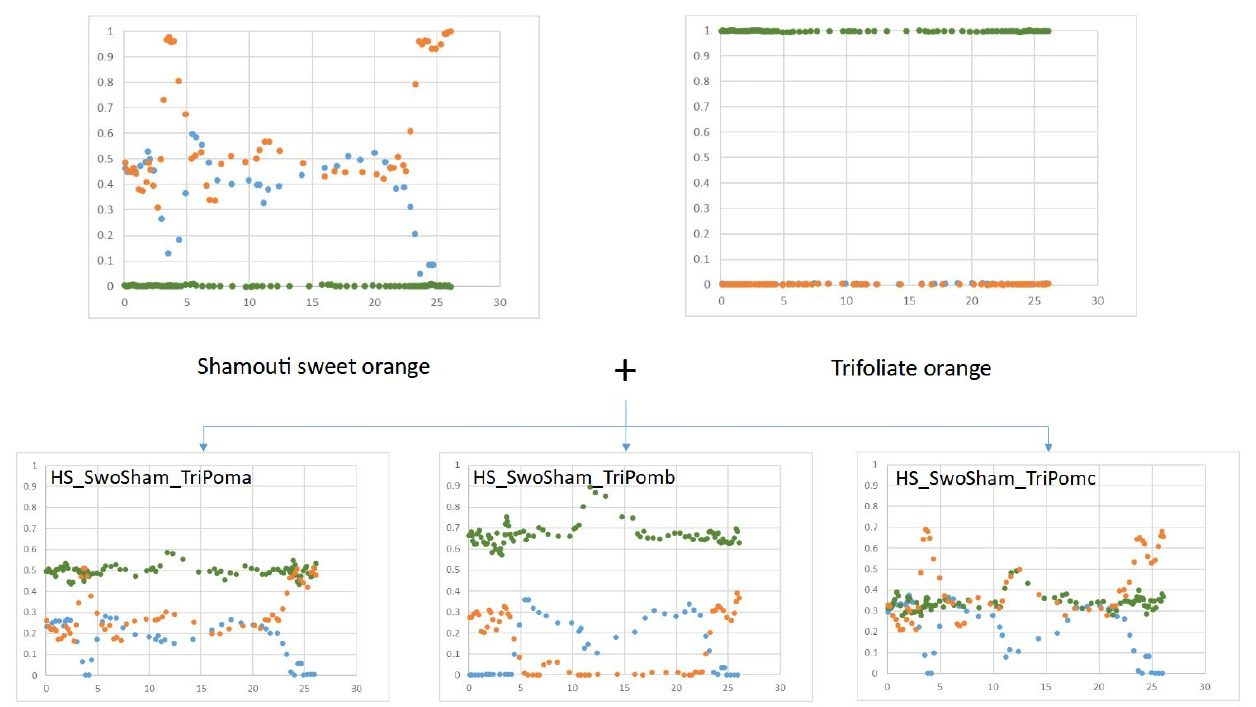
Figure 6. Frequencies of the diagnostic alleles of the three ancestral genomes along Chr9 of three somatic hybrids between C. sinensis cv Shamouti and P. trifoliata cv Pomeroy. Green: P. trifoliata ; orange: C. reticulata ; blue: C. maxima . The unit of the x axes is Mb. We analyzed three plants obtained from the combination between Shamouti sweet orange and Pomeroy trifoliate orange (Figure 6). For Chr9, HS_SwoSham_TriPoma displayed a logical profile for a teraploid, resulting from the addition of sweet orange and trifoliate orange all along the chromosome with a frequency for P. trifoliata around 0.5 and an alternation of C. maxima and C. reticulata together at 0.25 or C. reticulata alone at 0.5. For HS_SwoSham_TriPomb, the P. trifoliata read dose was greater than 0.66 all along the chromosome, while C. reticulata and C. maxima alternated around 0.33. The most plausible configuration is triploid with two doses of P. trifoliata and the loss of one chromosome from sweet orange ( C. maxima fragment from 0 to 2 MB and then C. reticulata to the end). For the HS_SwoSham_TriPomc somatic hybrid, the profile was consistent with a triploid configuration with the loss of one chromosome from P. trifoliata . For all three plants as well as sweet orange, we observed a decrease for C. maxima reads and an increase for the other ancestors around 12 Mb, which may be explained by a loss of pummelo genomic region in the centromeric area of sweet orange Chr9.